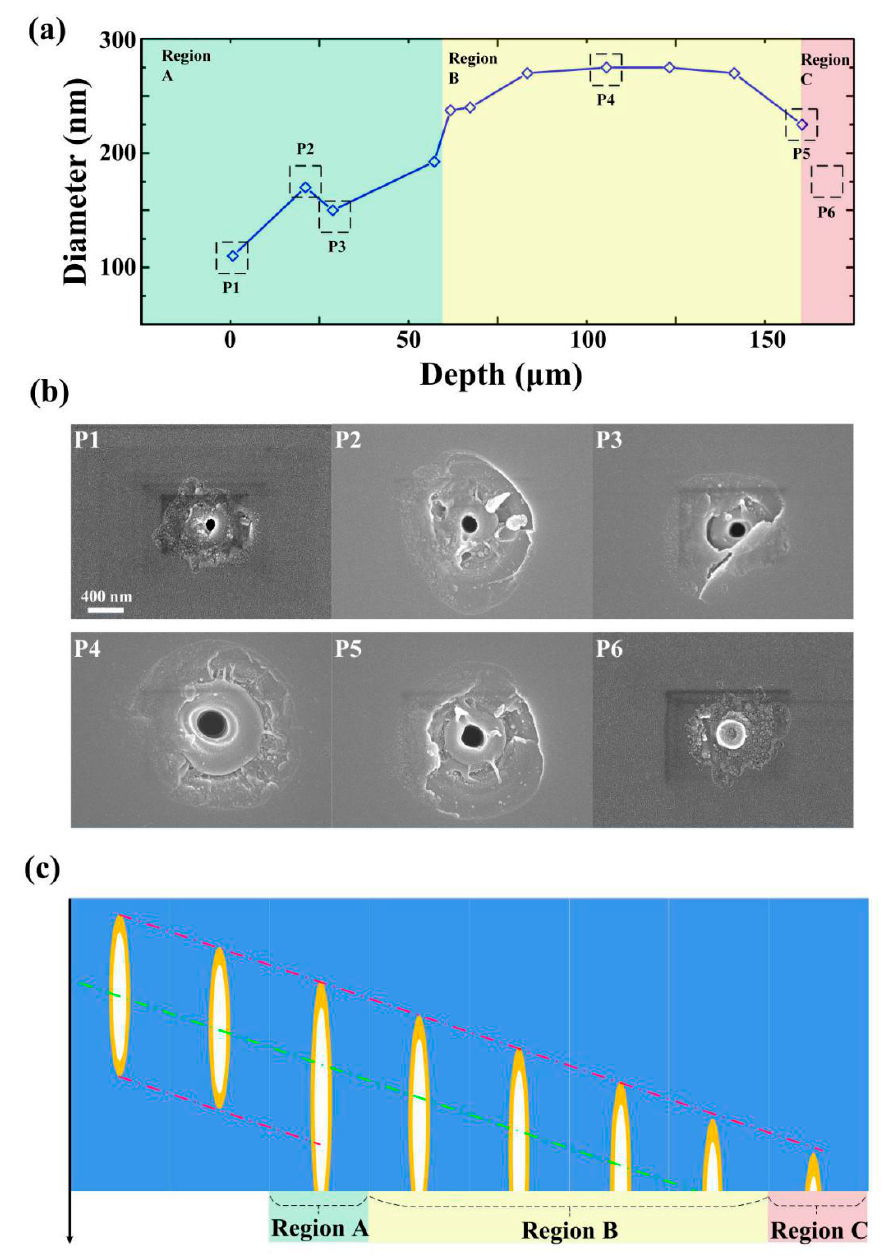
Figure 8. Effect of the relative position of the pulse beams to the exit surface on nano-structures ( a ) Nano-holes diameter corresponding to three different morphology-based region (uniquely colored zones) of Bessel beam irradiation on the exit surface of fused silica. ( b ) The nano-structures on the bottom surface which are induced by 1.5 ps, 8 μ J/pulse single pulse laser beams are presented corresponding to the different positions. ( c ) Schematic diagram of confined micro explosion and liquid expulsion taking place in Region A, Region B, and Region C. The dot green line shows the symmetry plane of the Bessel beam, located in the middle of the interference region. The red line represents the bottom of the laser-modified region, which surrounds the nano-hole.